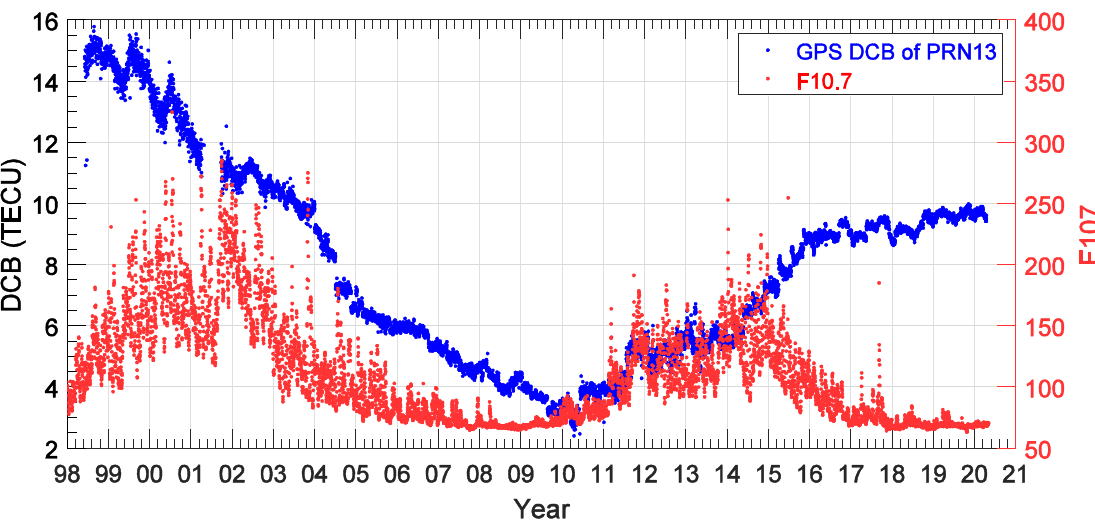
Figure 1. Variations of the International Global Navigation Satellite System (GNSS) Service (IGS) Global Positioning System (GPS) differential code bias (DCB) of Pseudo Random Number (PRN) 13 and solar activity proxy F10.7 from 1998 to 2020.